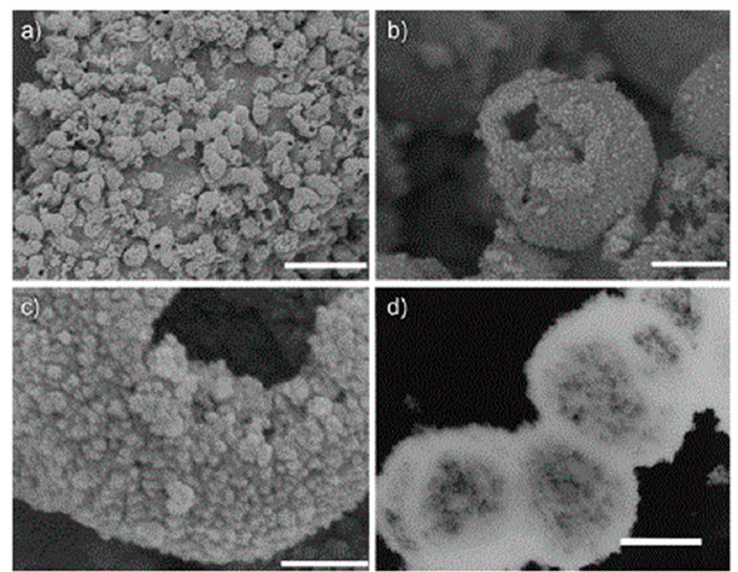
Figure 4. Large-scale synthesis of porous TiO 2 hollow aggregates reported by Liu et al. The synthesis is carried out using a low-temperature hydrothermal method without templates. ( a – c ) Field-emission scanning electron microscopy (FESEM) analyses at di ff erent magnifications and ( d ) transmission electron microscope (TEM) micrograph of the “as prepared” sample by one-step hydrothermal treatment at 160 ◦ C for 6 h. The scale bars for ( a – d ) are 5 mm, 500 nm, 100 nm, and 500 nm, respectively. The low-magnification FESEM micrograph ( a ) of the sample indicates that the aggregates are composed of a large amount of NPs. While, the micrograph ( b ) shows the hollow interior of the single aggregate and the micrograph ( c ) at a higher magnification highlights the porous structure of the TiO 2 NP aggregates. Moreover, the hollow structure of the TiO 2 sample is confirmed by TEM micrograph ( d ). Reproduced with permission from [62]. Copyright © 2018 John Wiley and Sons.